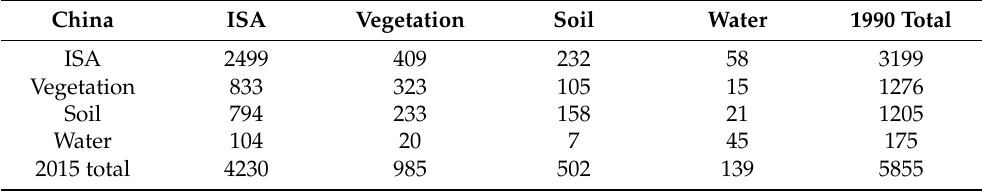
Table 2. Land-cover changes (km 2 ) in the old urban areas between 1990 and 2015. China ISA Vegetation Soil Water 1990 Total ISA 2499 409 232 58 3199 Vegetation 833 323 105 15 1276 Soil 794 233 158 1205 Water 104 2015